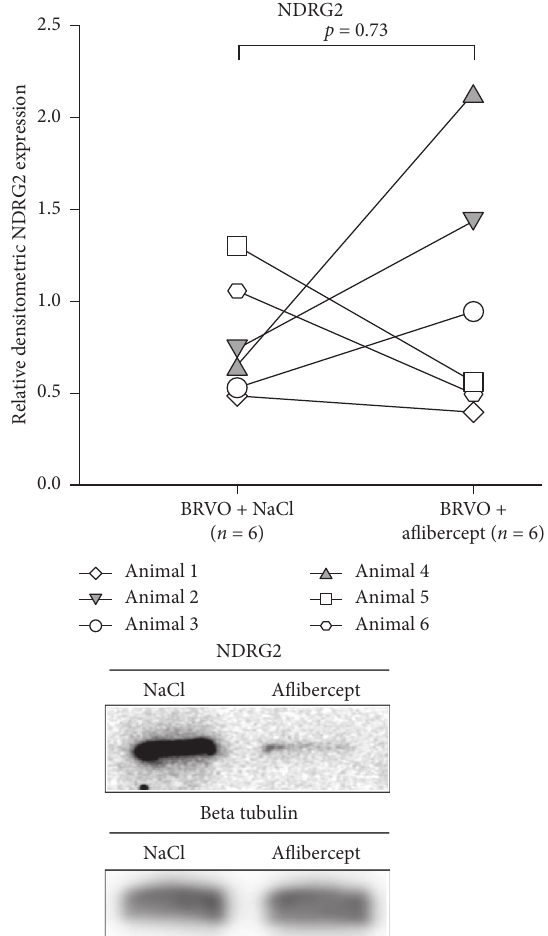
Figure 3: Proteomic analysis by mass spectrometry revealed a downregulation of NDRG2 in the BRVO model following aflibercept intervention. However, the downregulation of NDRG2 was not sufficiently large to be confirmed with Western blotting ( p � 0 .